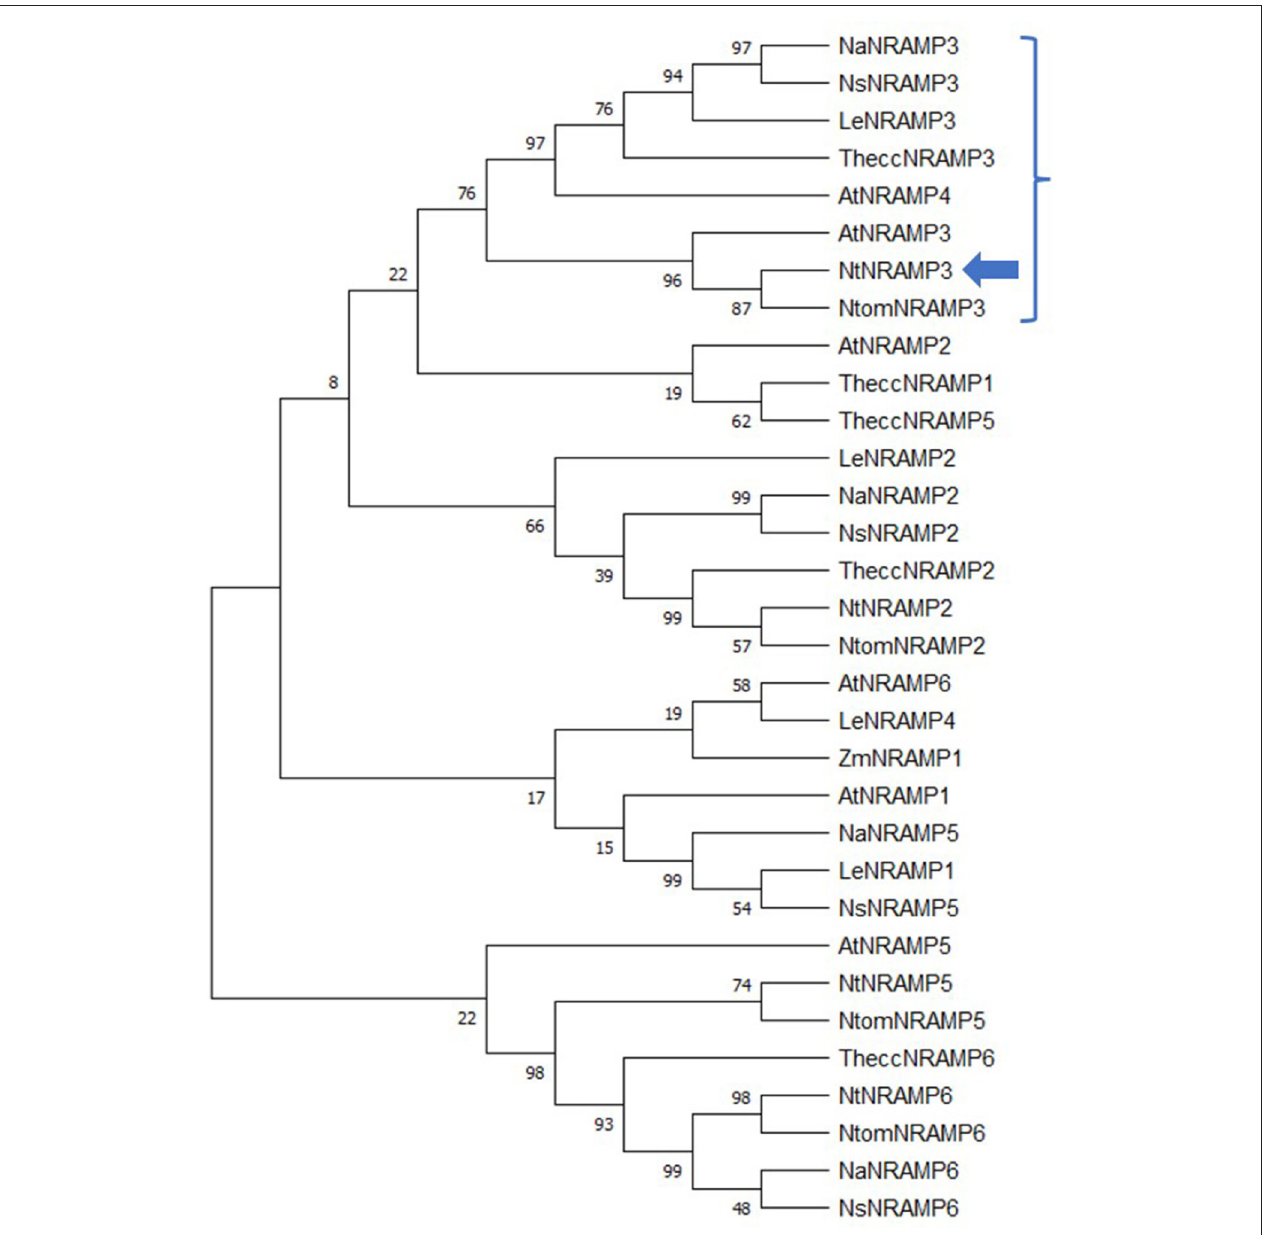
FIGURE 1 | A phylogenetic tree of the natural resistance-associated macrophage protein (NRAMP) transporters from Arabidopsis thaliana , Solanum lycopersicum , Zea mays , Theobroma cacao , and Nicotiana . Amino acid sequences of the 32 NRAMP proteins were identified in the ARAMEMNON ( A.thaliana ), Solgenomics ( S. lycopersicum ), MaizeSequence ( Z. mays ), Phytozome ( T. cacao ), and NCBI ( Nicotiana ) databases. The phylogenetic tree was constructed with the MEGA X software using Neighbor-Joining method. The length of branches corresponds to the degree of divergence. Numbers in the figure represent bootstrap values (1,000